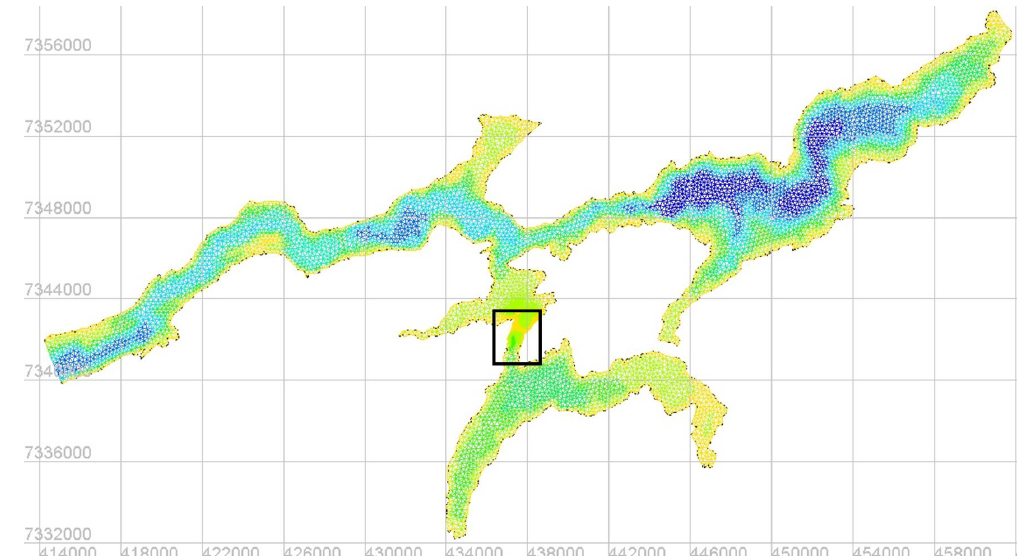
Figure 3. Modelled area and mesh for the TELEMAC simulation. The Skarpsundet sound is shown within the square.